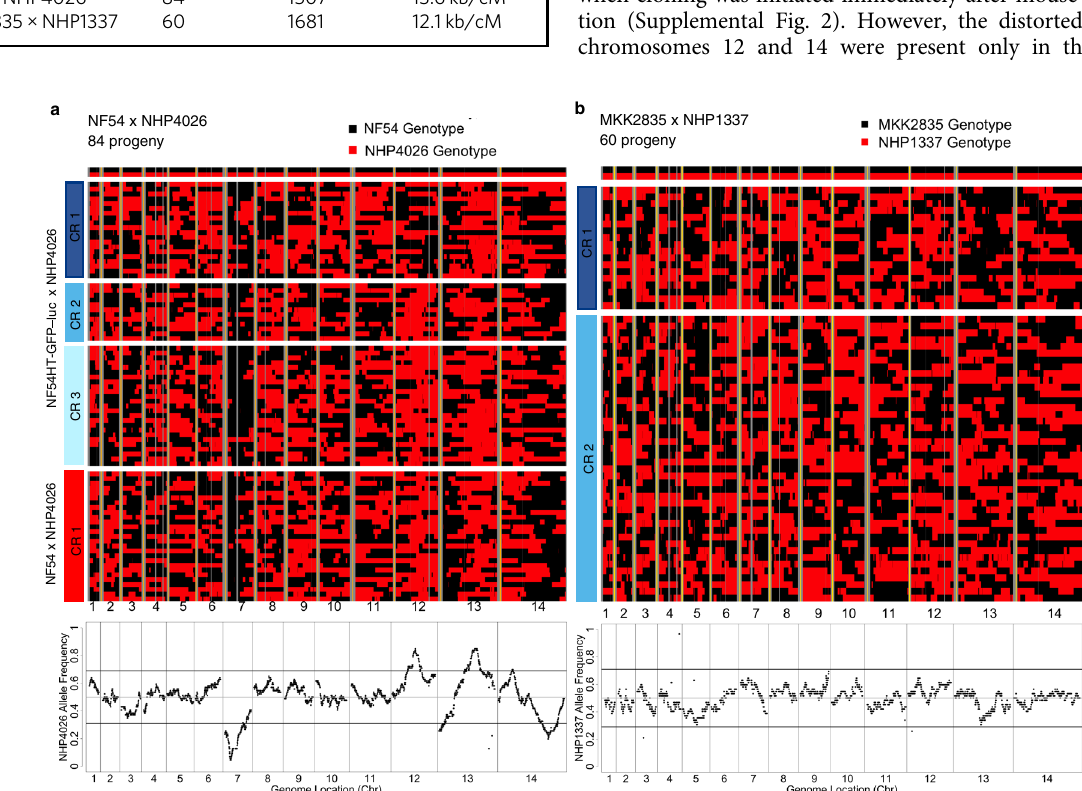
Fig. 3 Physical maps of recombinant progeny from two genetic crosses. Physical maps ( a , b ) depict inheritance patterns in 5 kb blocks across the core genome 21 ( x axis) for each progeny ( y axis). Non-core regions of the genome with no variant calls are shown in gray and yellow shows chromosome boundaries. Each heatmap is broken into sections by cloning round. The lower panels show allele frequencies across the genome for the unique recombinant progeny and the horizontal black lines show a cut-off for segregation distortion, a deviation from the expected ratio of 1:1 at p = 0.001. a The physical map for the NF54 × NHP4026 progeny shows regions where haplotype blocks deviate signi fi cantly from the expected 1:1 ratio. b The physical map for MKK2835 × NHP1337 shows even inheritance ratios across the genome, in line with Mendelian